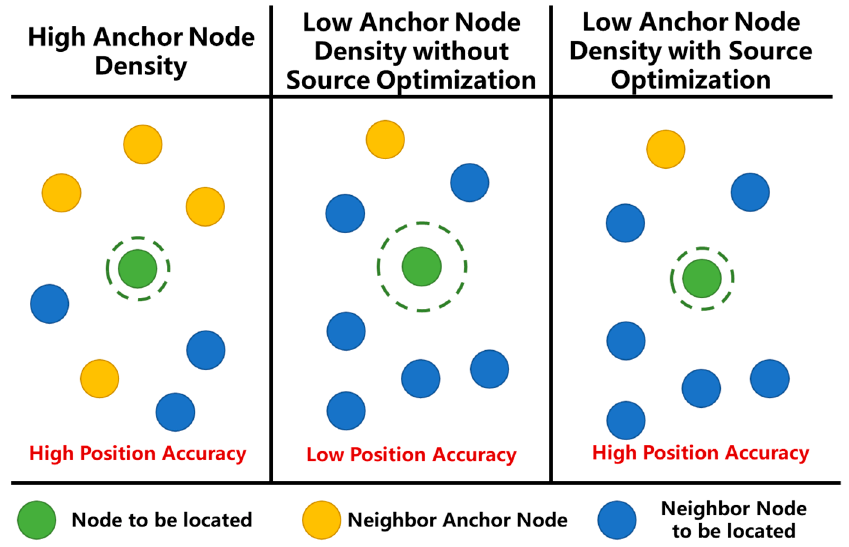
Figure 1. Different position accuracy with different anchor node density. Under low anchor node density, the number of neighbor nodes to be located in the position source increases, and the uncertainty of the localization information of the position source increases, resulting in a decrease in the position accuracy of the node to be located.